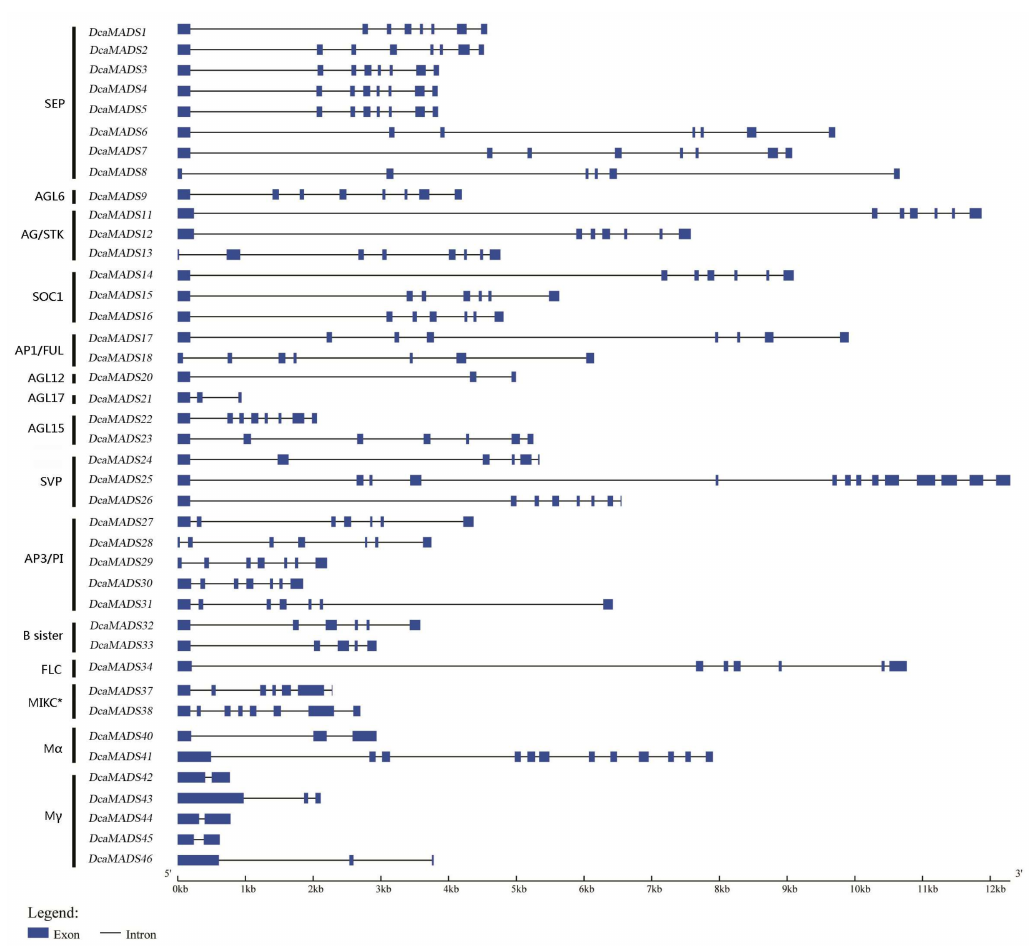
Figure 1. The exon-intron structure of DcaMADS genes. The lines indicate introns, and the blue boxes indicate exons.